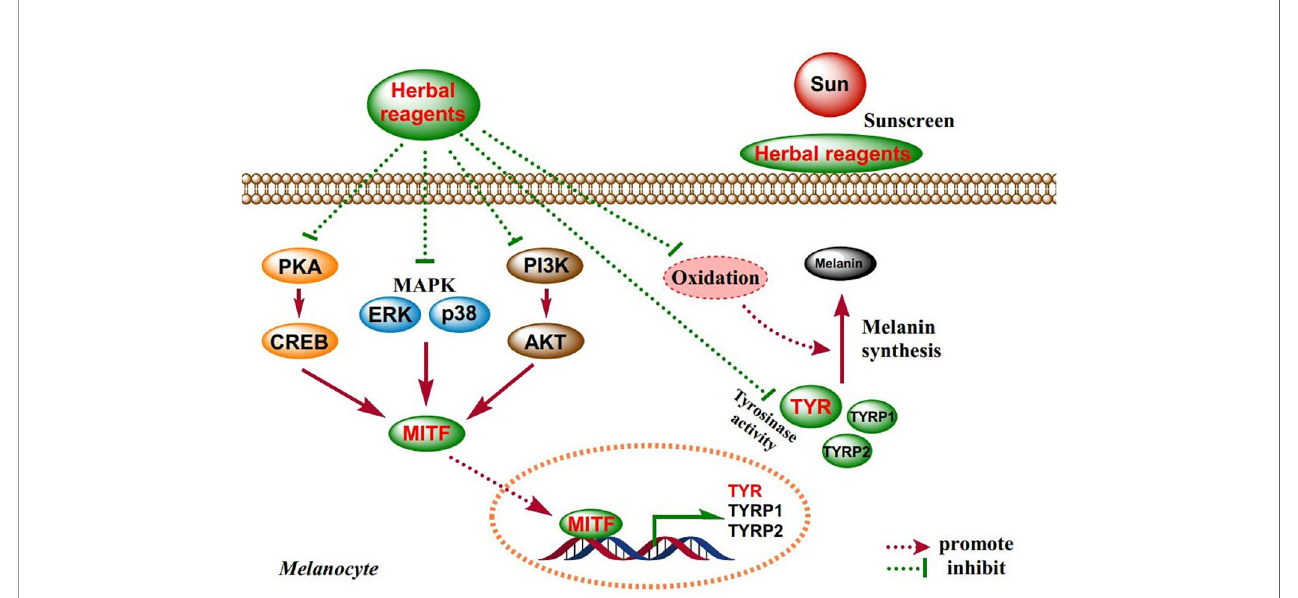
FIGURE 3 | Schematic diagram of the mechanisms of herbal reagents in 90